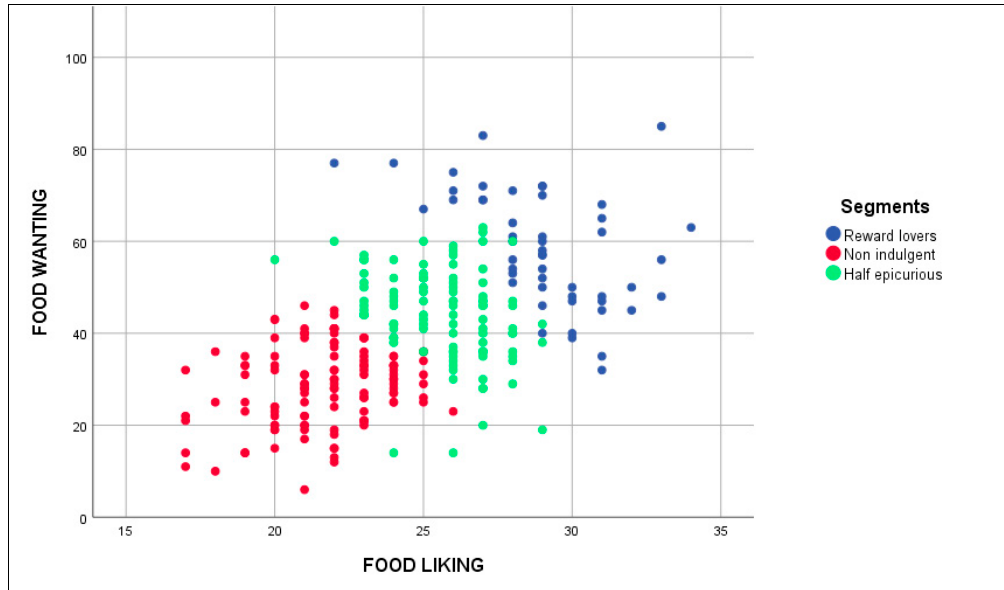
Figure 3. Segments positioning based on food liking and food wanting total scores.